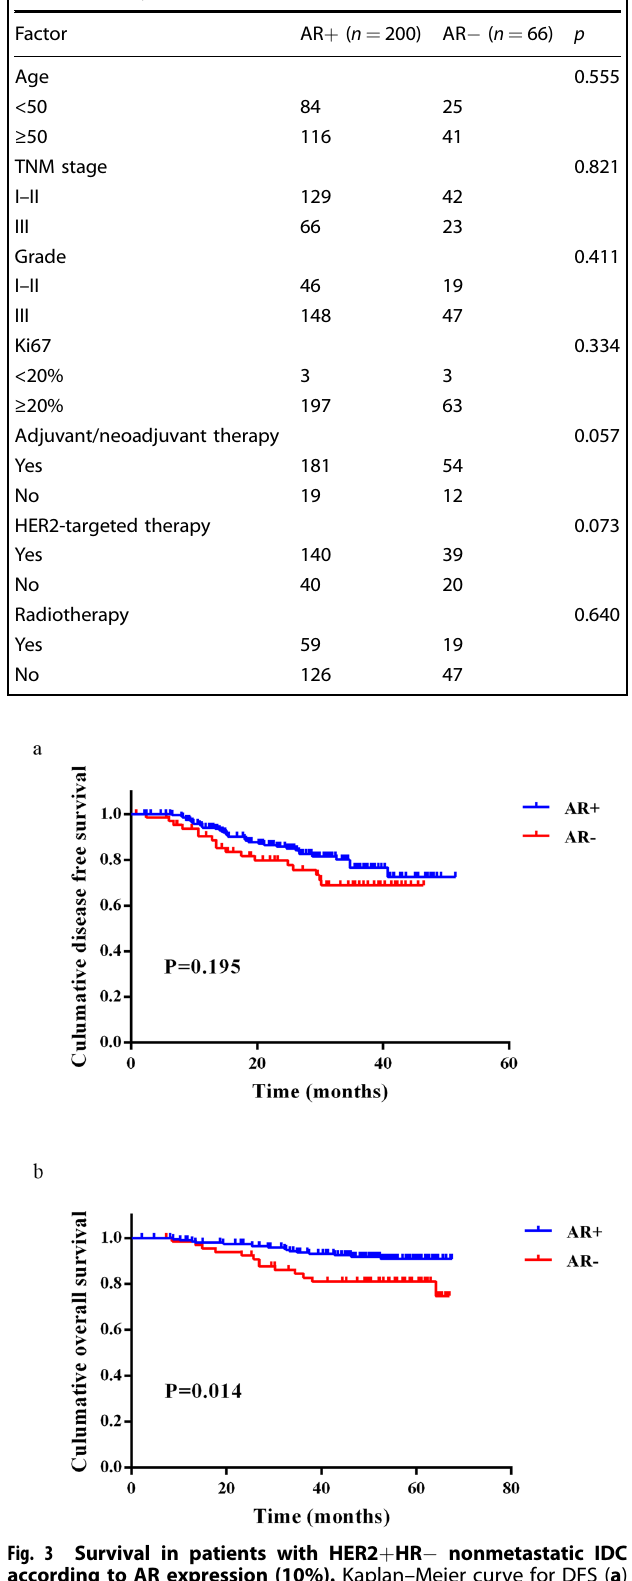
Table 2. Clinicopathological characteristics of 266 HER2 + HR − breast IDC patients by chi-square test.